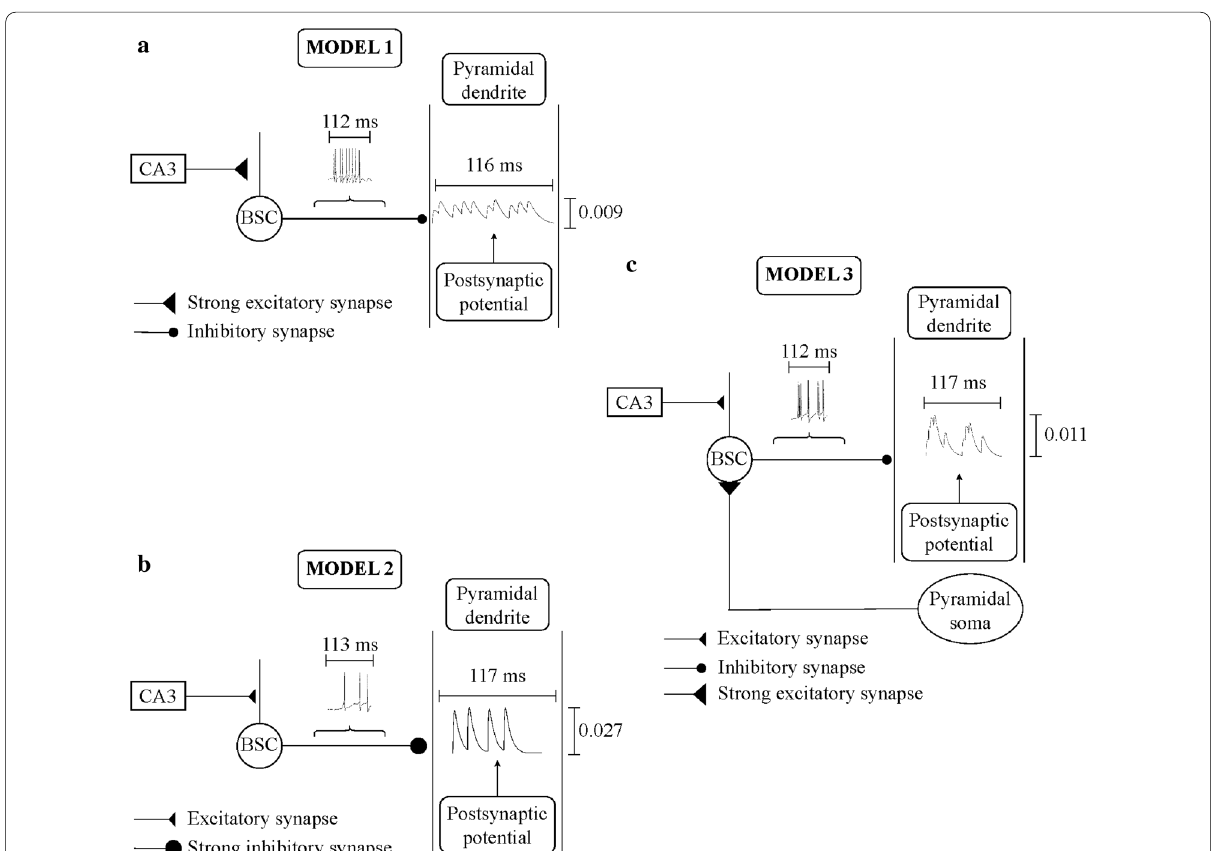
Fig. 6 Schematic drawing of a ‘model 1’, b ‘model 2’, and c ‘model 3’. In ‘model 1’, a strong excitatory CA3 input increases BSC firing response, which generates on PC dendrite numerous small amplitude IPSPs, thus producing a very strong inhibitory environment which filters out spurious neuronal activities. In ‘model 2’ a strong BSC inhibitory drive to PC dendrite causes postsynaptically fewer, but with larger amplitude IPSPs. In ‘model 3’, a strong excitatory PC feedback signal to BSC increases its firing response, which generates fewer than ‘model 1’ IPSPs on PC dendrite, and hence a less strong inhibitory environment than ‘model